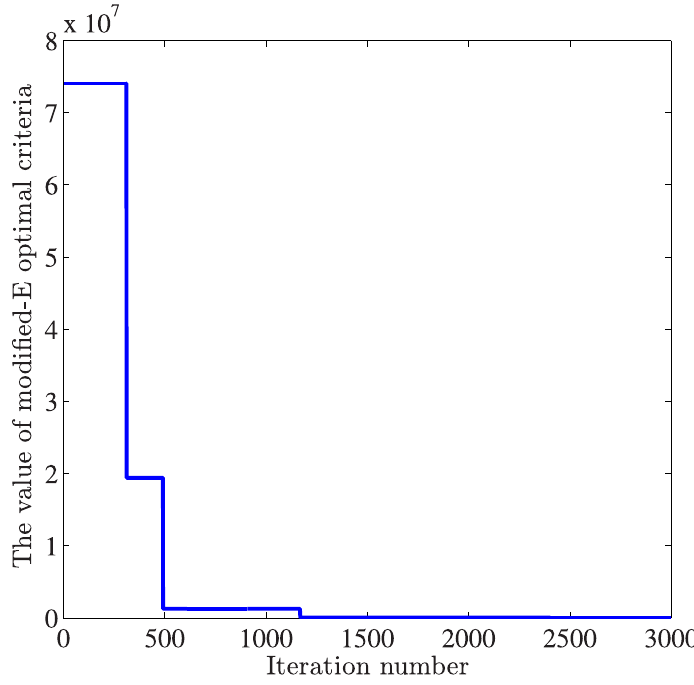
Fig 10. Trajectories of the modified E-optimality criteria using HS-OED algorithm. In the outer loop, the value of modified-E optimal criteria decreases as the value of fitness function is minimized by the proposed HS-OED method.